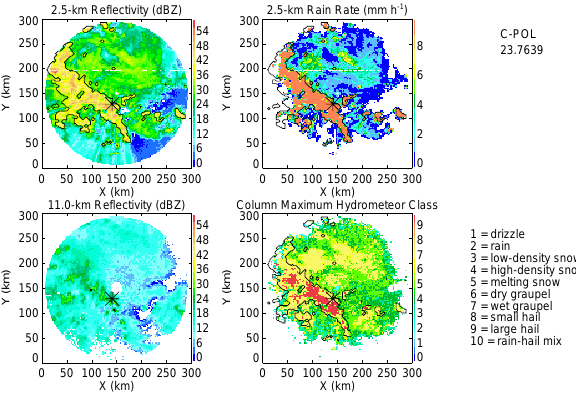
Figure 13. Cross sections from C-POL radar fields when the S- band experienced stratiform rain at 23.8958 (cf. Fig. 8): Z e and rain rate at 2.5km altitude, Z e at 11km altitude, and column maximum hydrometeor class (see legend). The location of the S-band profiler is marked with an asterisk. Areas outlined in black are identified as convective (see text) except in the 11km Z e field, where they enclose areas greater than 30dBZ (only present in Fig. 14).